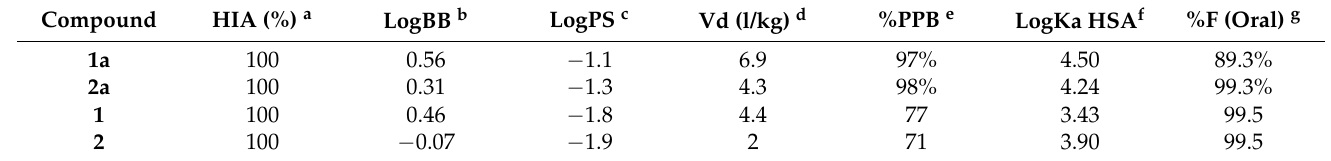
Table 2. Calculated ADME parameters related to absorption and distribution properties as referred to 1a, 2a previously discovered mTAAR5 antagonists and to the newly screened 1 and 2. a HIA represents the human intestinal absorption, expressed as percentage of the molecule able to pass through the intestinal membrane. b Extent of brain penetration based on ratio of total drug concentrations in tissue and plasma at steady-state conditions. c Rate of brain penetration. PS represents permeability–surface area product and is derived from the kinetic equation of capillary transport d prediction of volume of distribution (Vd) of the compound in the body; e eplasmatic protein binding event; f ligand affinity toward human serum albumin; g oral bioavailability as a